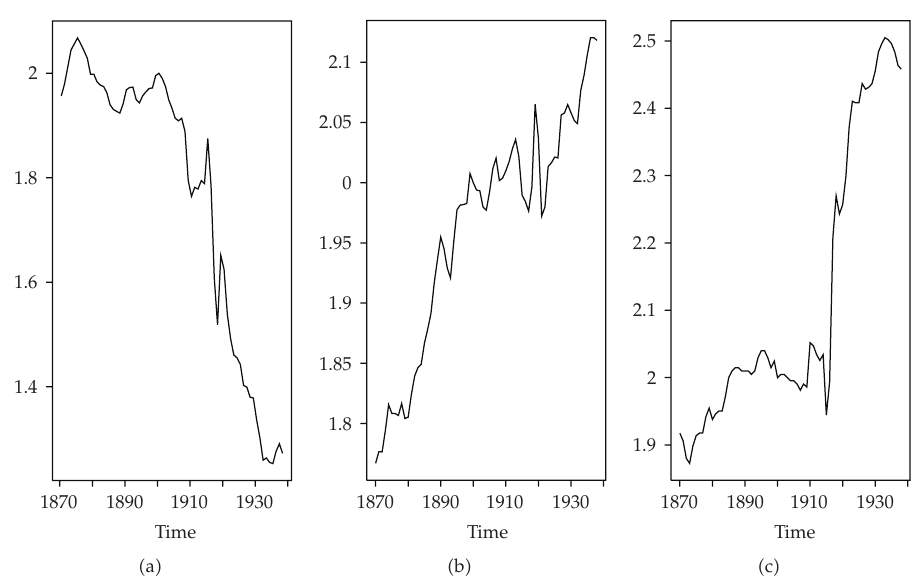
Figure 2: Application data-set: (cid:3) a (cid:6) : y i (cid:7) log (cid:3) the annual per capita consumption of spirits (cid:6) ; (cid:3) b (cid:6) : x i 1 (cid:7) log (cid:3) per capita income (cid:6) ; (cid:3) c (cid:6) : x i 2 (cid:7) log (cid:3) price of spirits (cid:6) .